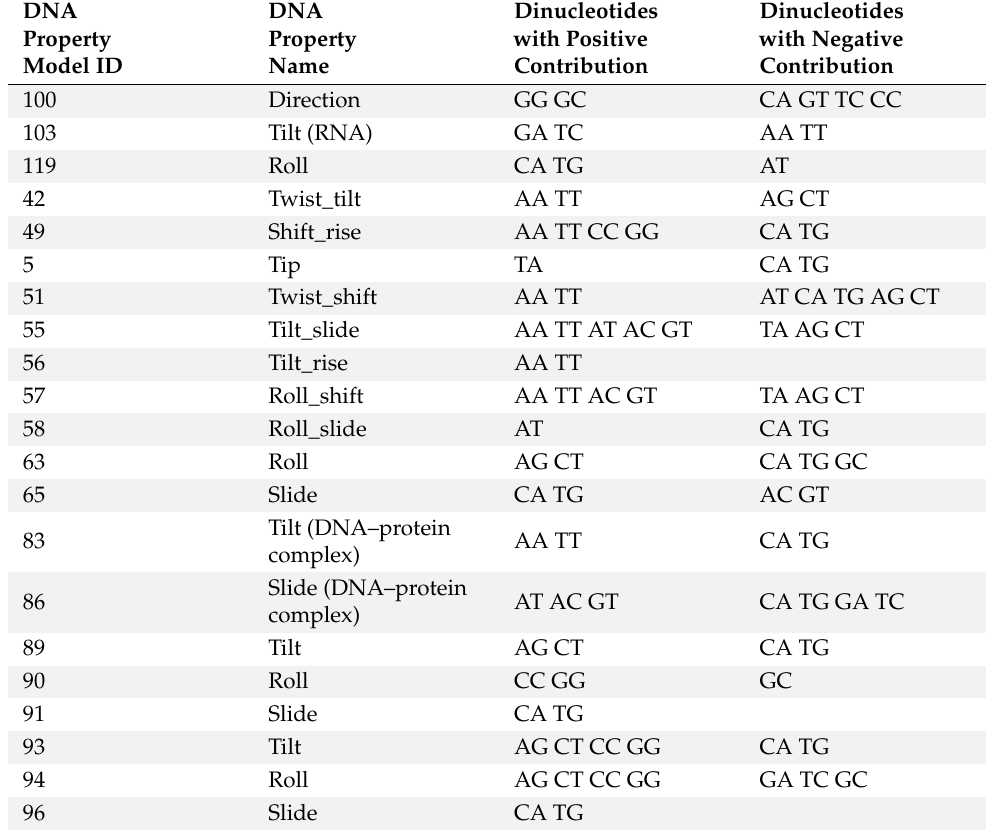
Table 3. Dinucleotides with significant contributions to DNA properties. Dinucleotides with contents significantly contributing to physical or conformational DNA properties (see Section 2.5 for details on calculation). The DNA property model IDs and DNA property names were taken from the were taken from the dinucleotide properties database [6]. Different IDs for the same property name represent different models for the same property. Dinucleotide leading to absolute changes of the property < 10% are not listed. DNA properties without any significantly contributing dinucleotides leading to changes larger the 10% are not listed (see Table S4). Contributions with significance levels above >1 σ were considered significant (see Figure 5 or Table